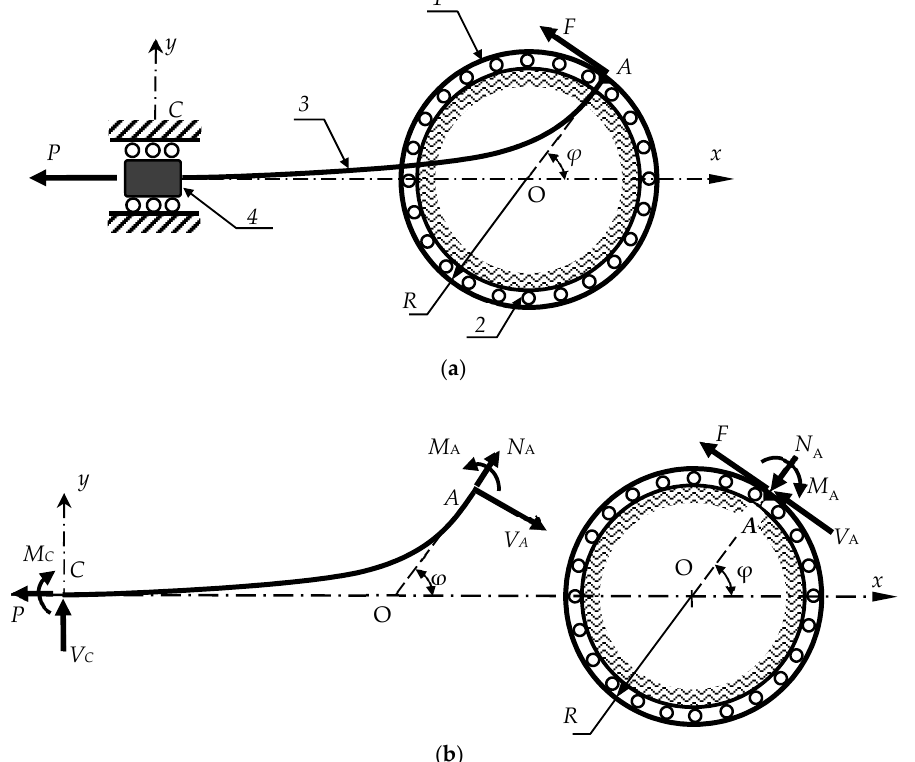
Figure 1. ( a ) Scheme of a stand for testing systems, including a tensile rod with an end sliding along a circular guide: 1—curved guide, placed on bearing 2; 3—elastic rod; 4—sliding guide; ( b ) forces in the rod section and forces acting on the curved guide. Note that V A and M A are internal forces acting in the rod at its connection to the curved guide, N A is the tensile force in the rod, F is the external force applied to obtain the transverse stiffness of the